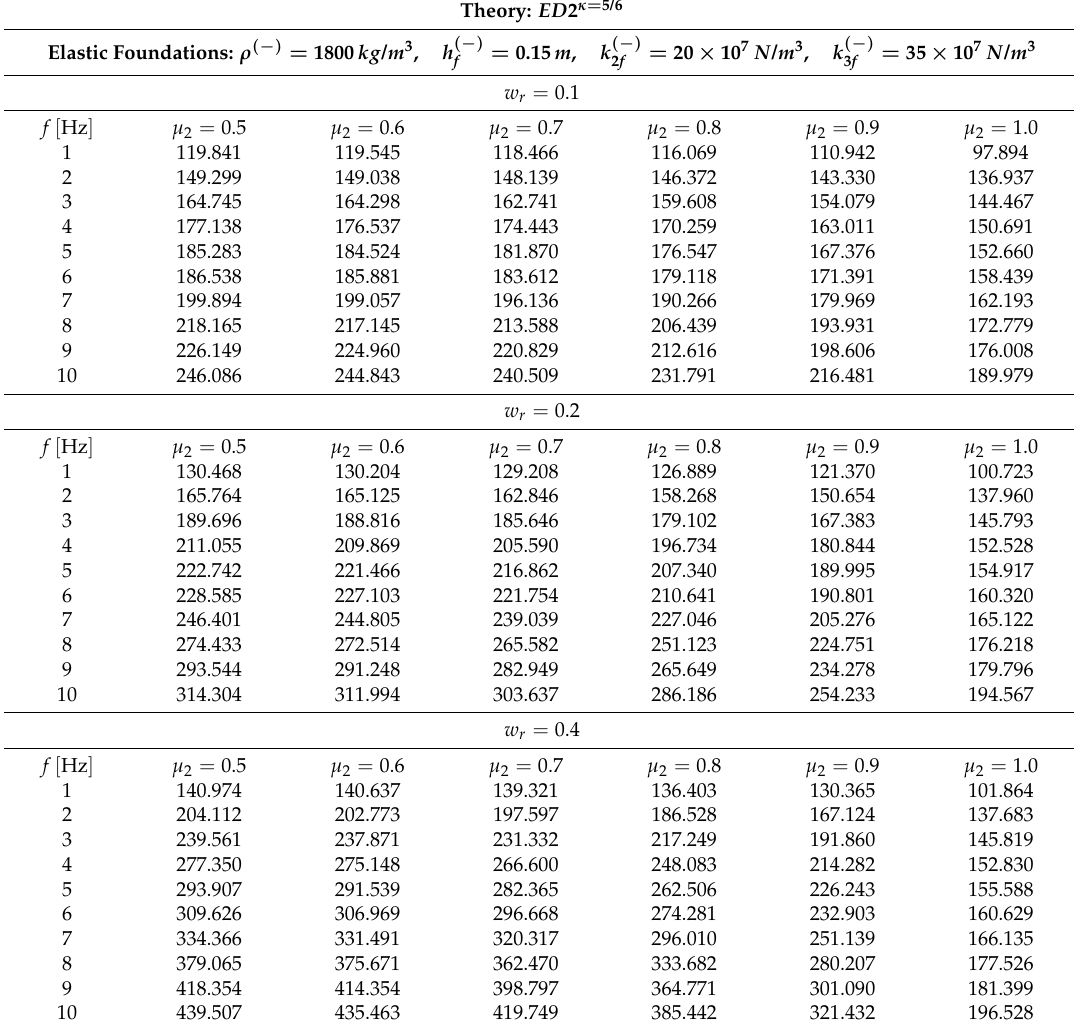
Table 18. First ten natural frequency variations for ED2 κ = 5/6 theory of a CCFF helicoidal surface (Figure 4c) reinforced by CNTs distributed as in Figure 5c for different mass fractions w r when varying the parameter of agglomeration µ 2 with µ 1 = 0.5. The Chebyshev-Gauss-Lobatto grid distribution was employed, with I N = 31, I M =